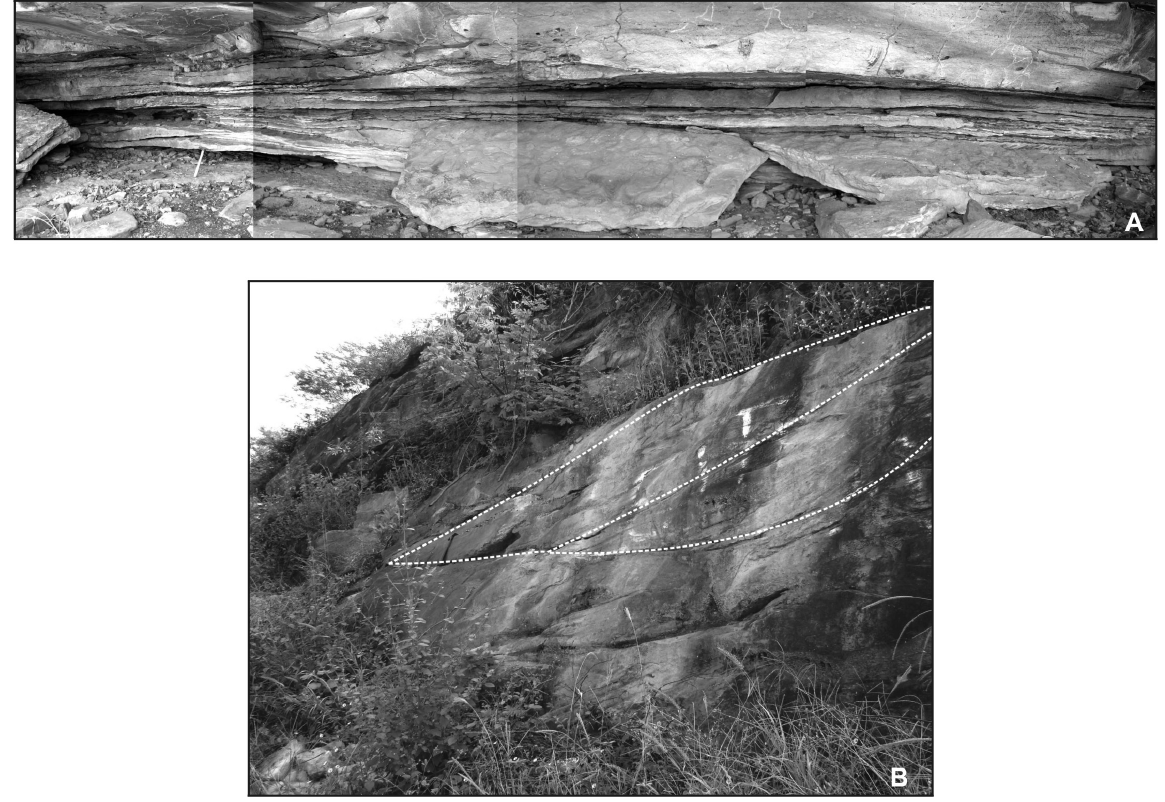
Fig. 4 – (A) Mouth-bar deposits in the Passagem Member, Oiti region (Pimenteiras, Piauí State), showing plane-bed laminae, climbing ripple cross-lamination and current ripples, interbedded with massive to laminated siltstones. (B) Sigmoidal clinoform typical of the upper mouth-bar portion, Passagem Member, BR-316 Highway, km 308, near Picos,